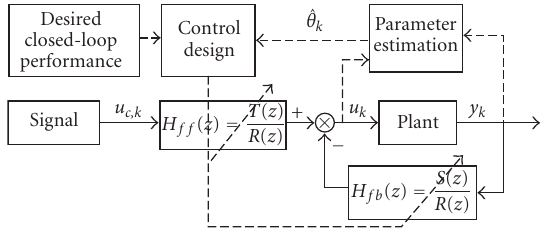
Figure 2.4. Basic adaptive